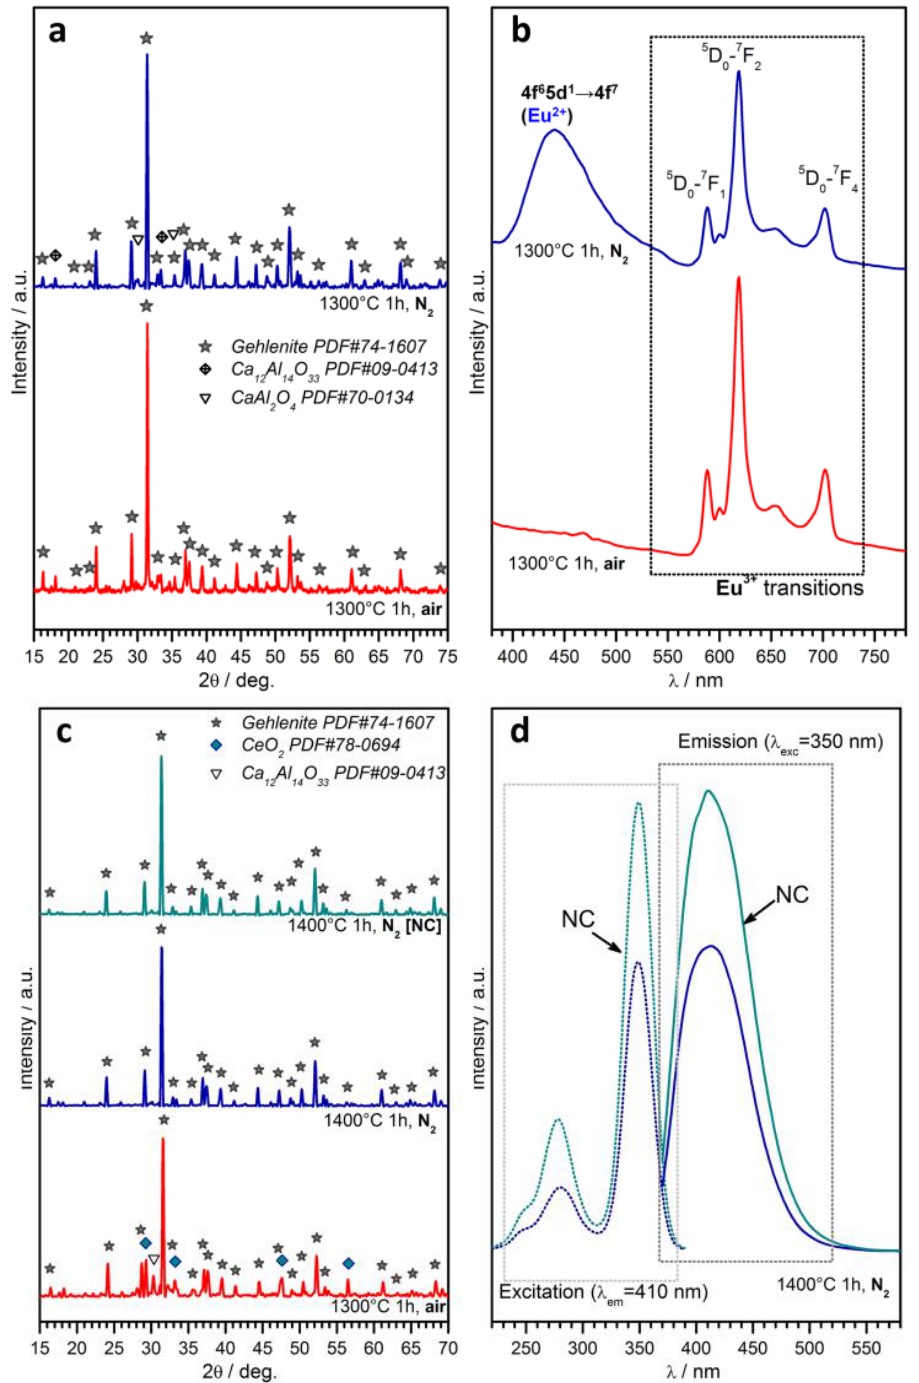
Figure 7. Development of polymer-derived gehlenite phosphors in air or in nitrogen atmosphere: ( a , b ) Eu-doped gehlenite (X-ray diffraction and